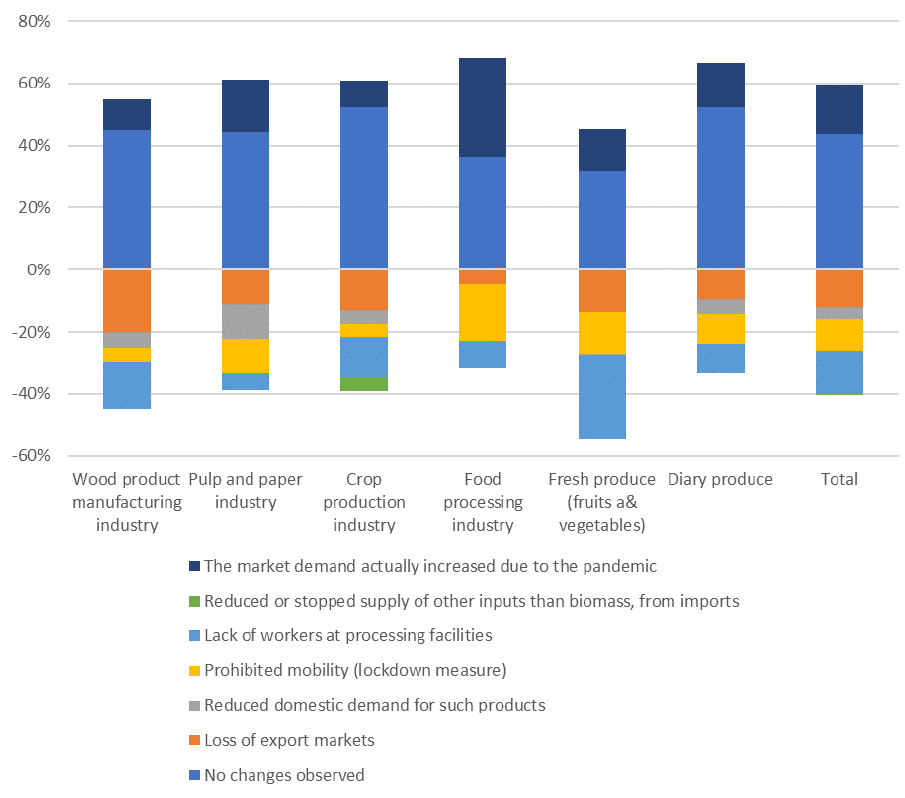
Figure A3. Aggregated results for economic disturbances in biomass supply chains from the supply side reported by experts.